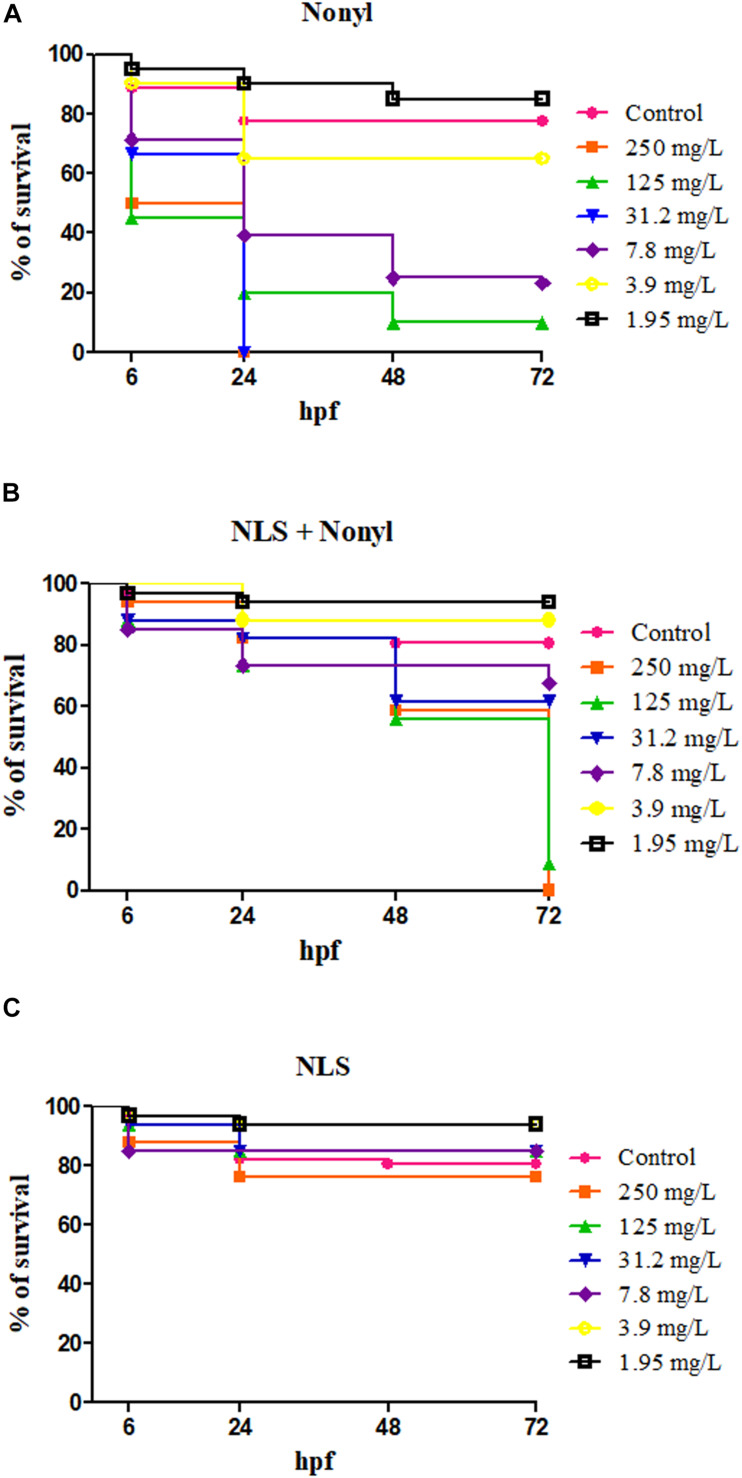
Survival curve of zebrafish embryos in contact with different concentrations, expressed in milligrams per liter (mg/L) of nonyl (A), nonyl incorporated into NLS (B) and NLS without the incorporation (C) after 6, 24, 48, and 72 h post-fertilization (hpf). The zebrafish embryos placed in contact with the nonyl incorporated to NLS showed a higher survival rate compared to the embryos placed in contact with the nonyl alone. The nanostructured system alone maintained embryos alive.